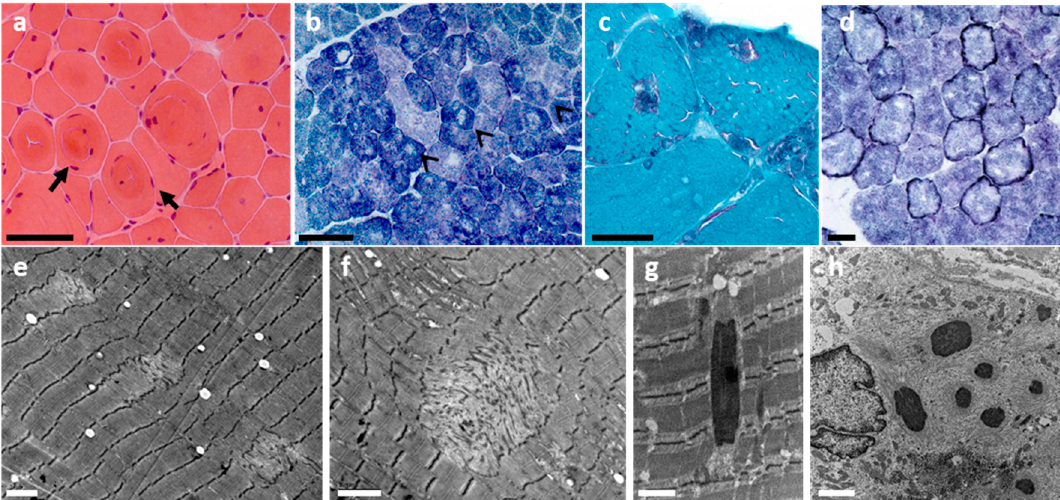
Figure 1. Histological spectrum of ASC1-related myopathy. Note histological features typical of a congenital myopathy such as fiber size variation ( a , b ), internalized nuclei ( a ) or whorled fibers ( a , black arrows). Multi-minicores are the main histological features and can be seen as multiple lighter areas lacking oxidative activity on oxidative staining (black arrowheads in b ) and areas of mitochondrial depletion and sarcomere disorganization on electron microscopy (EM; e , f ). Modified Gomori trichrome revealed in some patients multiple inclusions ( c ), which corresponded to electron-dense nemaline rods ( g ) on EM. Intense oxidative rims beneath the sarcolemma ( d , darker peripheral staining), compatible with mitochondrial proliferation or mislocalization, can be observed in some patients with TRIP4 mutations and are comparable to those reported in ASCC1 -mutated patients. Subsarcolemmal myofibrillar disorganization (sometimes forming cap lesions), cytoplasmic bodies and/rods can also be found ( h ). Transversal frozen sections: hematoxylin and eosin ( a ), NADH-TR ( b , d ), modified Gomori trichrome ( c );, EM ( e – h ). Scale bars = 50 μ m ( a , b ), 25 μ m ( c , d ), 2 μ m ( e , f , h ), 1 μ m ( g ). This figure has been modified from Ann Neurol 2020;87(2):217-232 and reproduced with permission from the publisher.